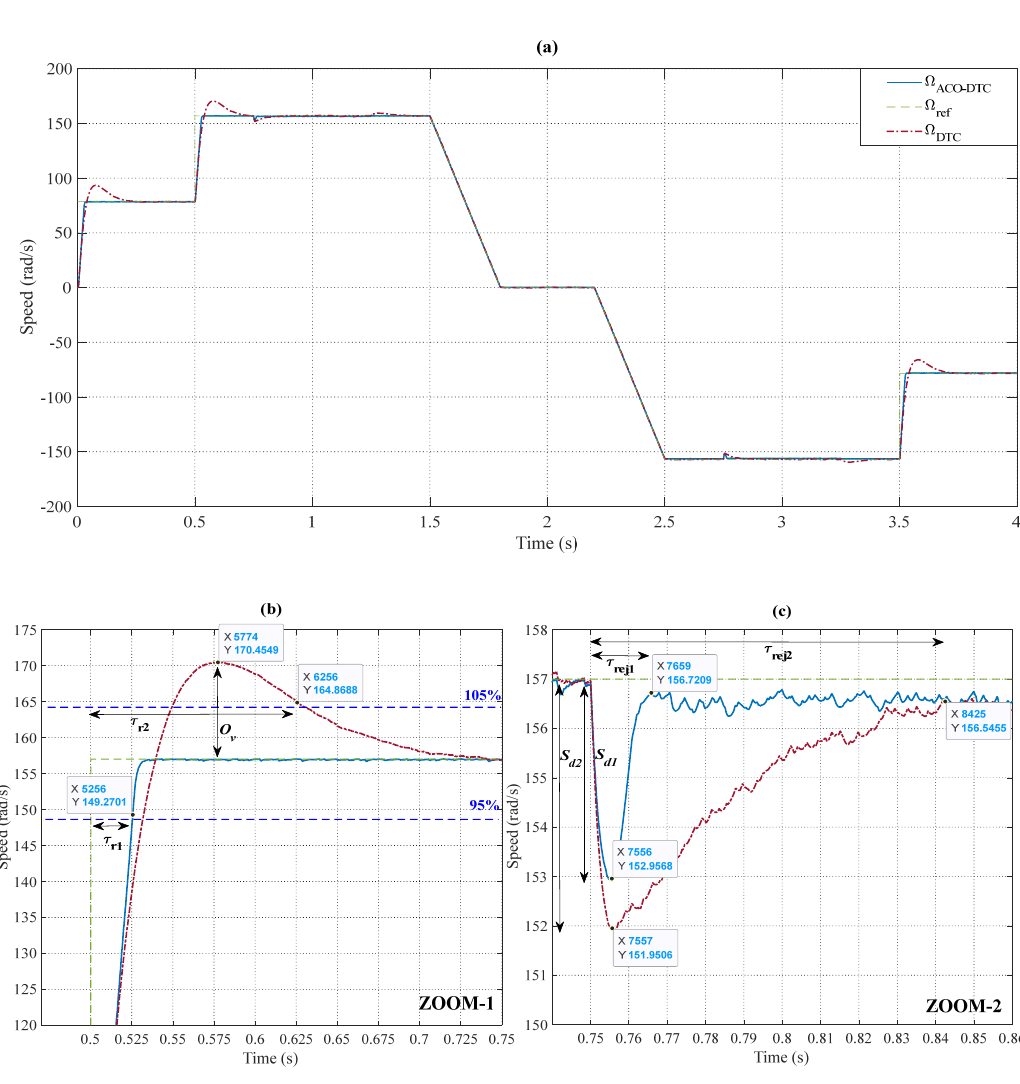
Figure 11. Speed responses ( a – c ) of classical DTC and intelligent ACO-DTC.